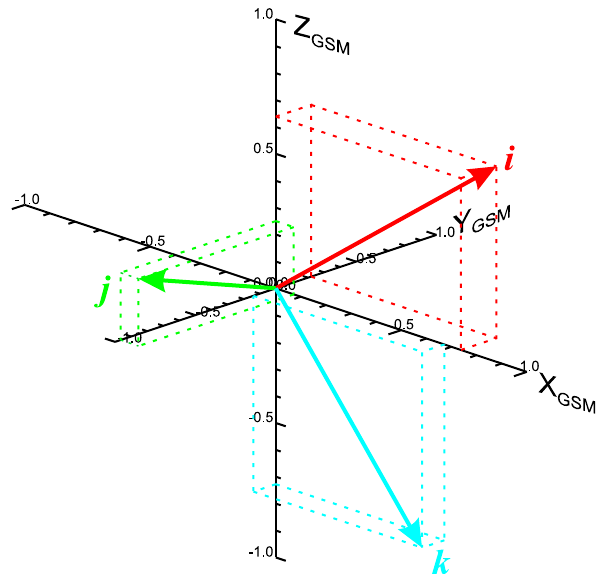
Fig. 7. The localised boundary normal unit vectors for the 15:18 UT FTE relative to the GSM coordinate system were ˆ i =[0.73, 0.25,